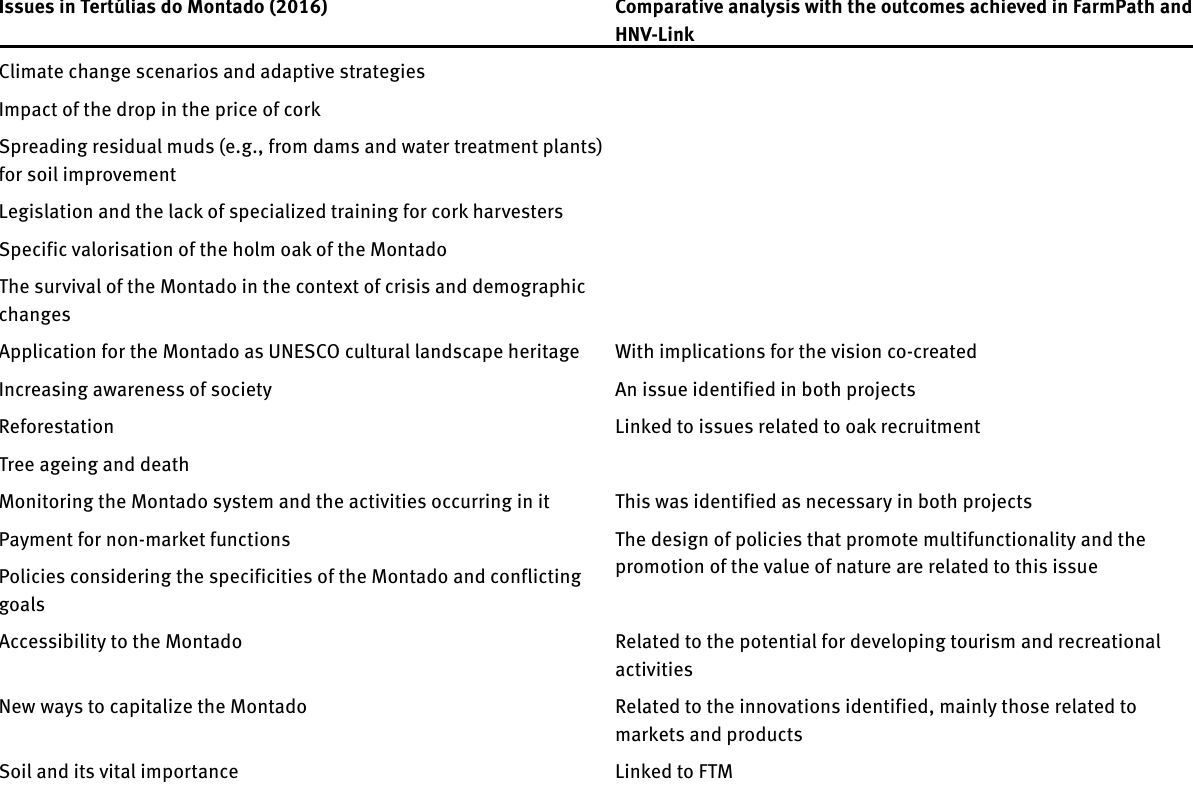
Table 2: The common agenda developed at the beginning of the Tertúlias do Montado initiative Issues in Tertúlias do Montado (2016) Comparative analysis with the outcomes achieved in FarmPath